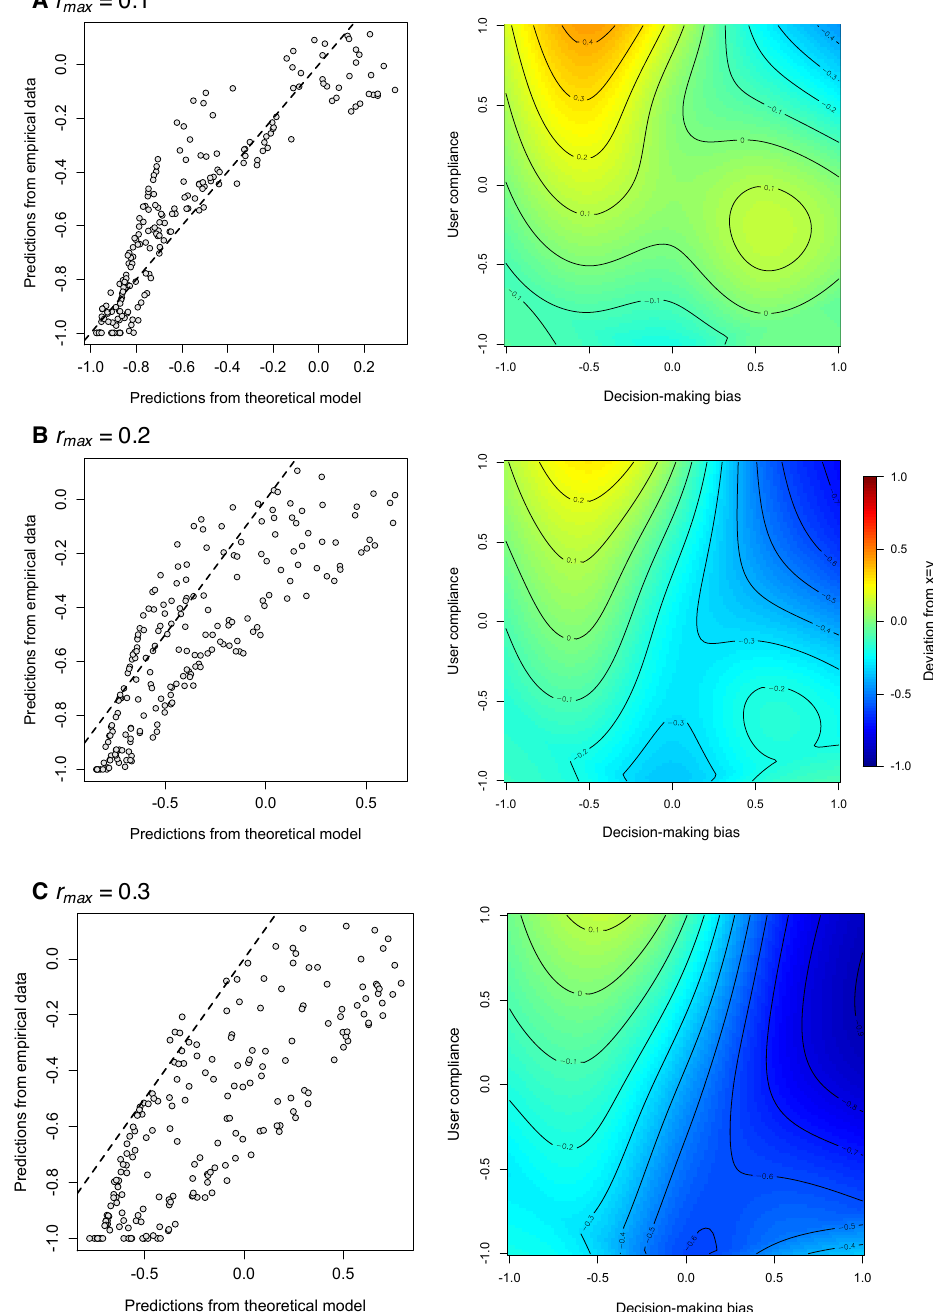
Fig. A7.1. Comparisons are shown for simulated intrinsic population growth rates of 0.1, 0.2 and 0.3. In each case, full grey circles denote a set of 200 random prediction coordinates, and the dashed line represents the x=y line. 2D contour plots show